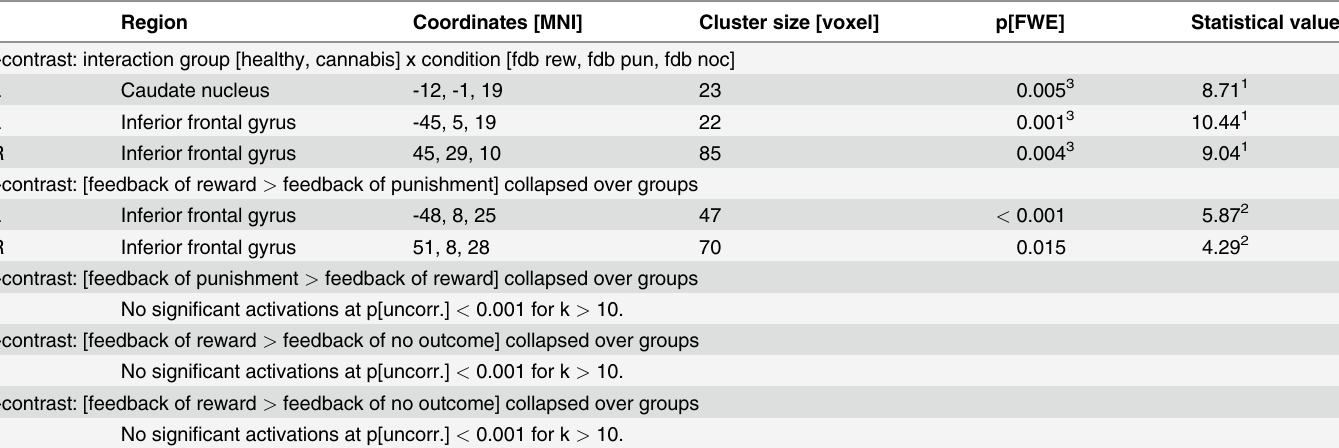
Table 3. List of activations related to the feedback period. Region